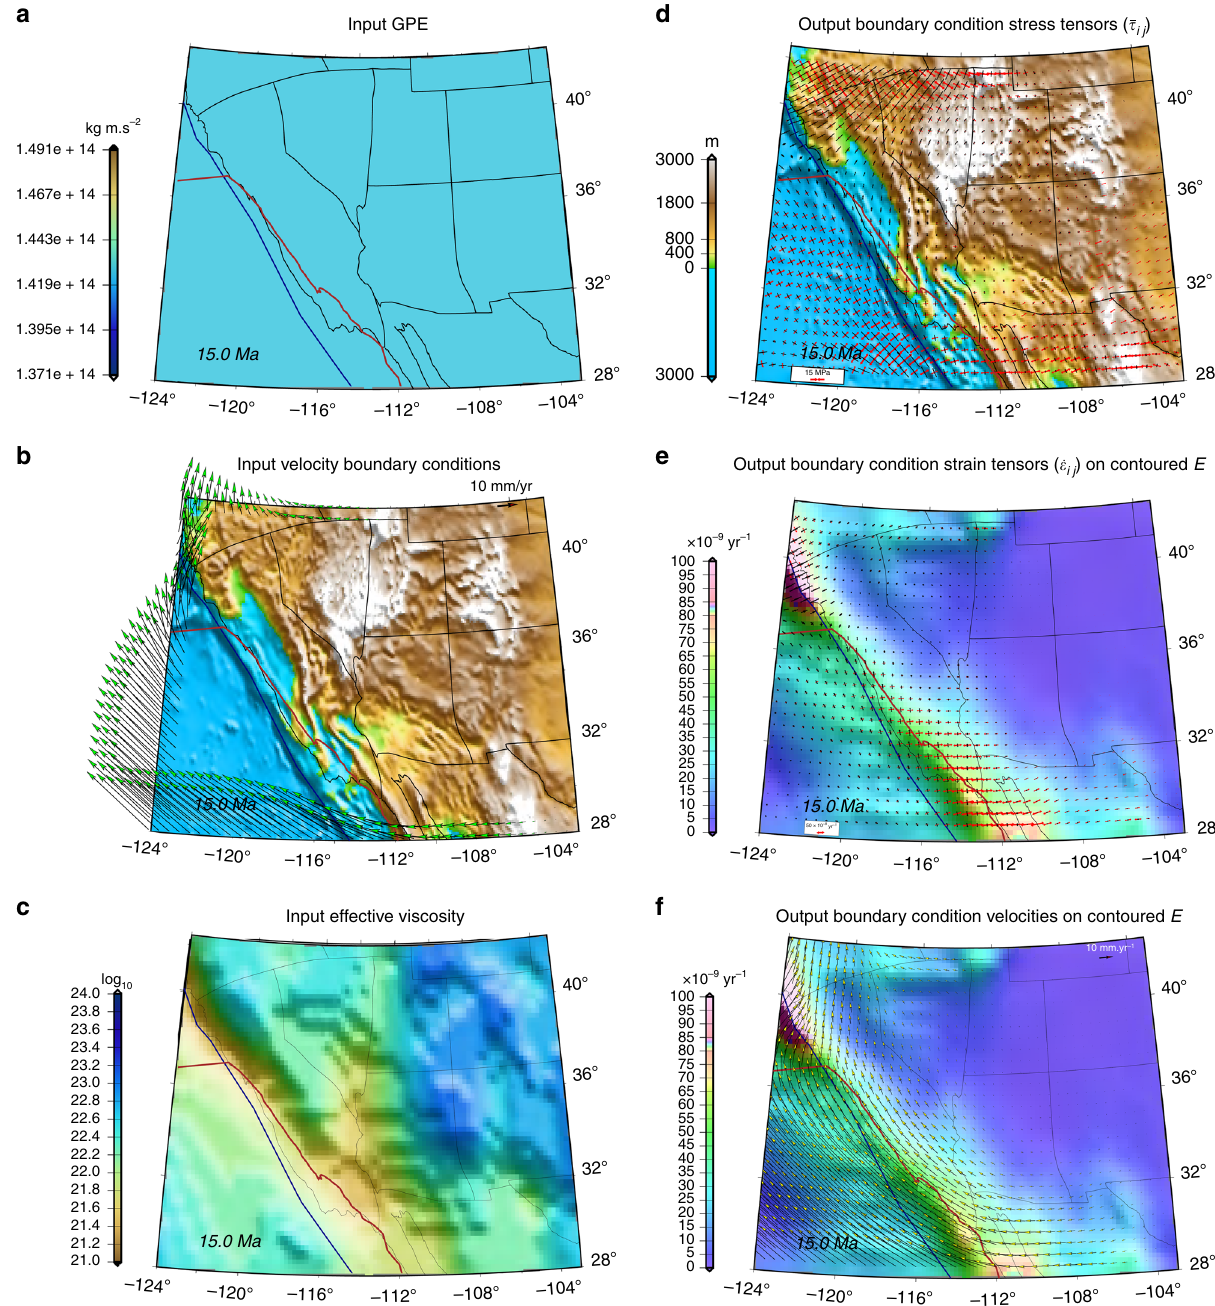
Fig. 5 Inputs and outputs for geodynamically constrained boundary conditions at Middle Miocene in southwestern North America. a Map of an initially constant GPE value for the lithosphere. b Boundary condition velocity estimates based on accommodation of Farallon- and Paci fi c-North America relative plate motions in southwestern North America. c Map of lithospheric effective viscosity obtained in fi nal iterative dynamic model. d Map of principal axes of lithospheric boundary condition stress tensors superimposed on paleo-elevation model of Bahadori et al. 8 . Red arrows represent tensional, and black arrows represent compressional principal axes of stress tensors. e Map of contoured second invariant of boundary condition strain rates ( E ) and principal axes of boundary condition strain tensors. Red arrows represent tensional, and black arrows represent compressional principal axes of strain tensors. f Map of contoured second invariant of boundary condition strain rates ( E ) and model boundary condition velocities relative to the North American frame. Red line in all panels represents reconstructed position of the East Paci fi c Rise and SAFS. Blue line in all panels represents reconstructed position